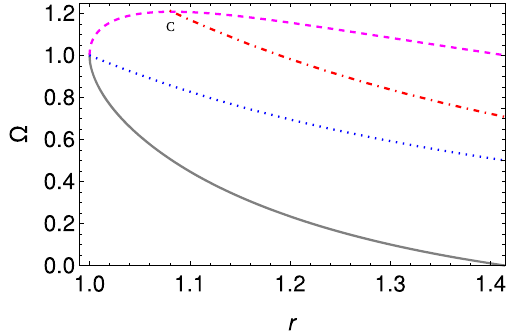
Fig. 1 Variation of (cid:3) (unit of ‘length − 1 ’) versus r (unit of ‘length’) for A = B = 1. (cid:3) cantakevaluesonlyintherange: ((cid:3) − ,(cid:3) + ) . (cid:3) + and (cid:3) − (unit of ‘length − 1 ’) are in dashed magenta and solid gray respectively and are plotted specifically inside the ergoregion, as a function of r . It is seen that (cid:3) ± meet at the horizon. The dotted blue line stands for the frequency of ZAMO (Zero Angular Momentum Observer), i.e., q = 0 . 5. The orbital frequency, i.e., (cid:3) φ = r E / r 2 (see Eq. A2) which is indicated by the dot-dashed red curve, crossed over the (cid:3) + curve at point ‘C’. It signifies that the observer moving with (cid:3) φ cannot continue